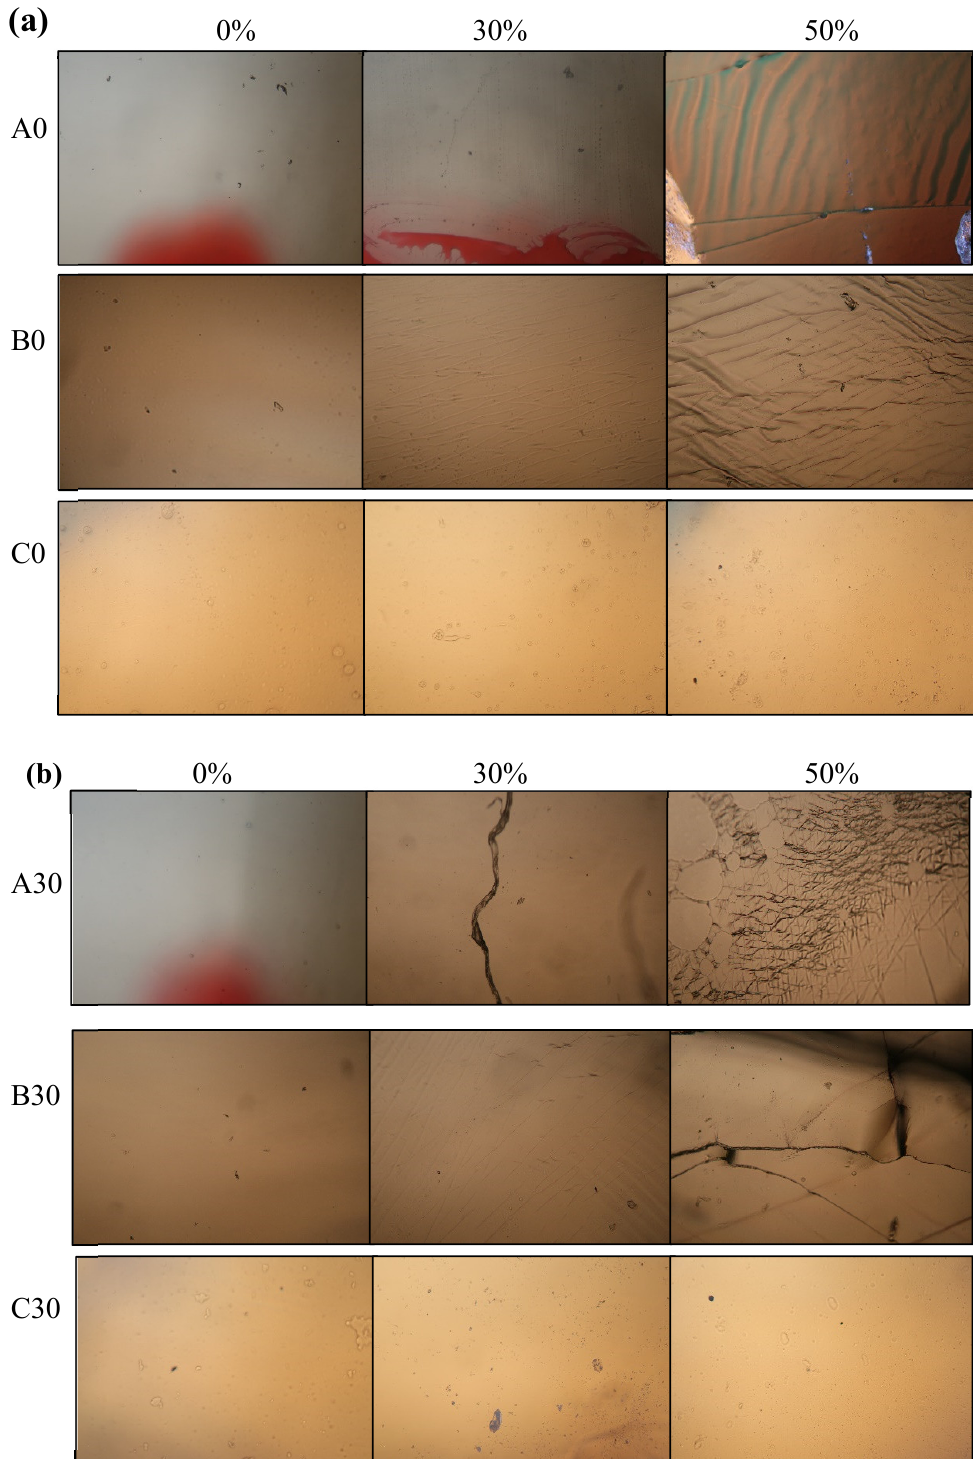
Figure 3. Optical microscopy images of ( a ) A0, B0, and C0 and of ( b ) A30, B30, and C30 thin films subject to various strain levels.